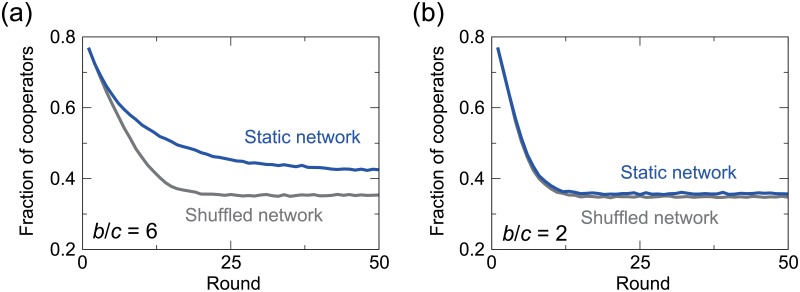
Fraction of cooperative players in each round, averaged over 103 simulations.We set k = 2, N = 100, tmax = 50, β = 0.2, A = 1.0, and ϵ = 0.05. (a) b/c = 6. (b) b/c = 2.